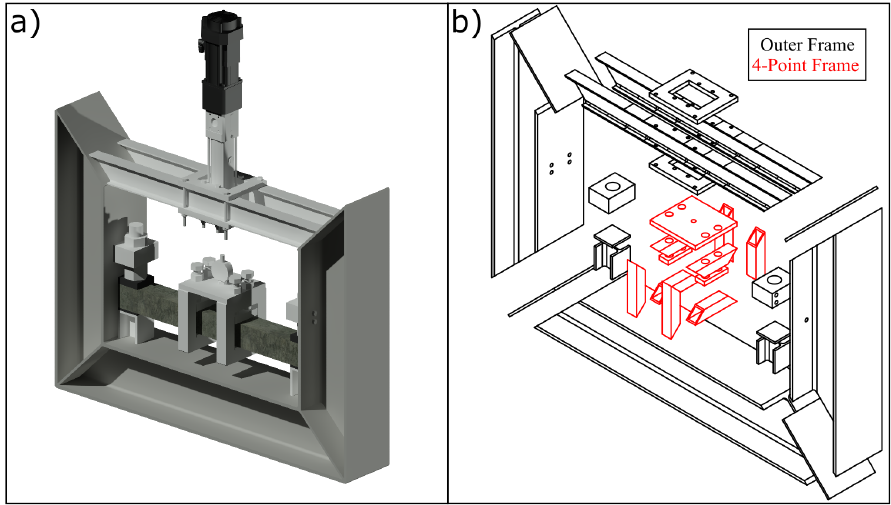
Figure 2. Isometric views of ( a ) rendered machine and ( b ) exploded